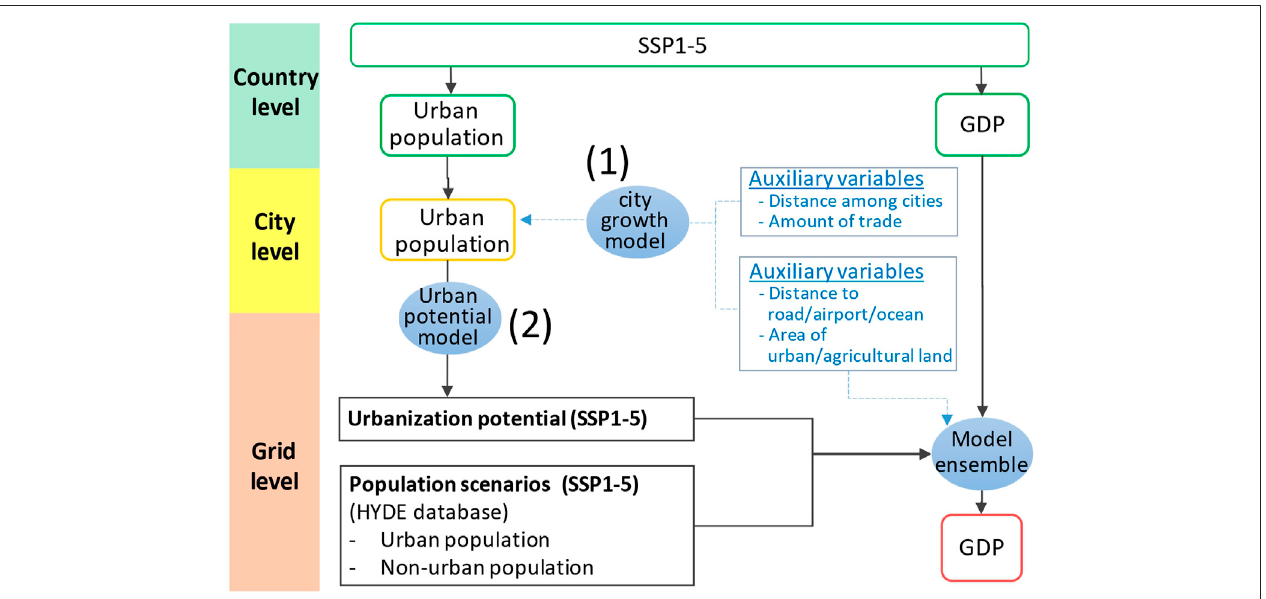
FIGURE 1 | Procedure for population and GDP downscaling (after 2020). Variables by countries, cities, and grids are coloured by green, yellow, and red, respectively. As this fi gure shows, the urban population was downscaled from countries to cities to estimate the potential of urbanization by the grids. The estimated potential under SSP 1 – 5 was used together with the grid population estimates, and other auxiliary variables in the model ensemble-based downscaling.